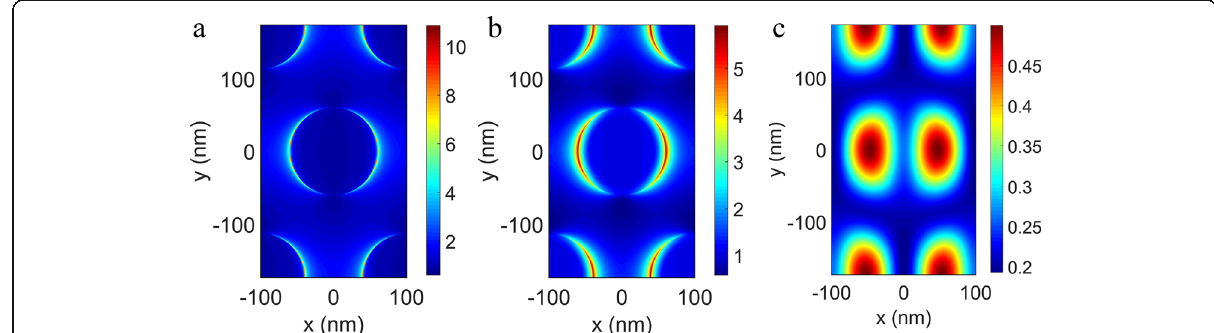
Fig. 7 The electric field distribution in the xy plane for resonant wavelength of 668 nm on a interface 1: the top TiN disk surface, b interface 2: the interface between the TiN disk and SiO 2 layer, and c interface 3: the interface between SiO 2 layer and bottom TiN